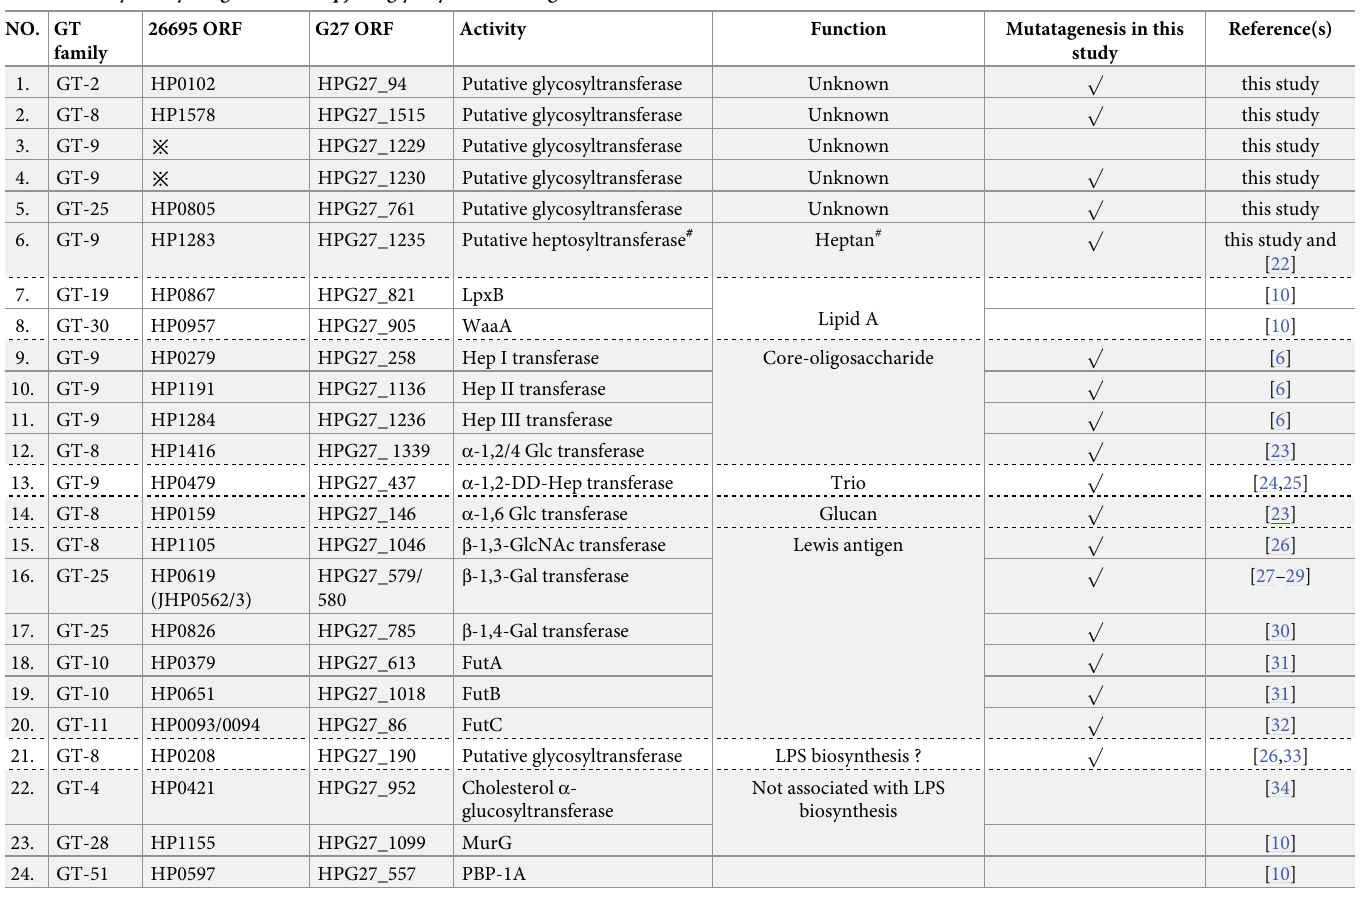
Table 1. CAZy family assignment of H . pylori glycosyltransferase